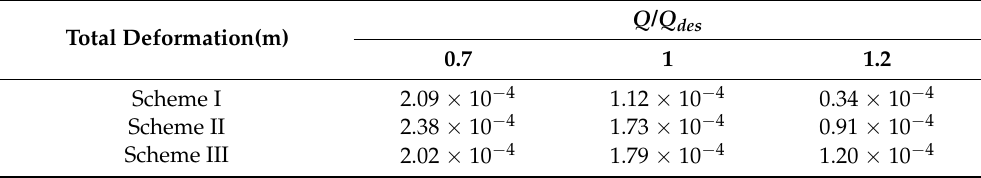
Figure 19. Impeller total deformation distribution under Q des in different schemes. ( a ) Scheme I. ( b ) Scheme II. ( c ) Scheme III. Table 3. Maximum total deformation of blades under different working